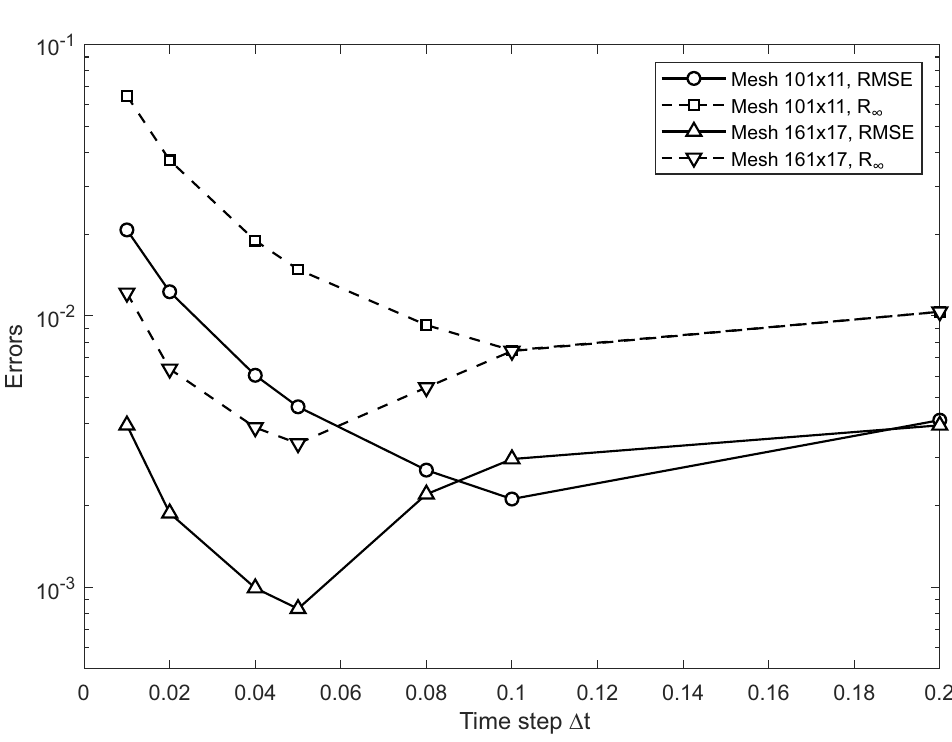
Figure 12. Example No. 3—RMSE and R ∞ as functions of the time step ∆